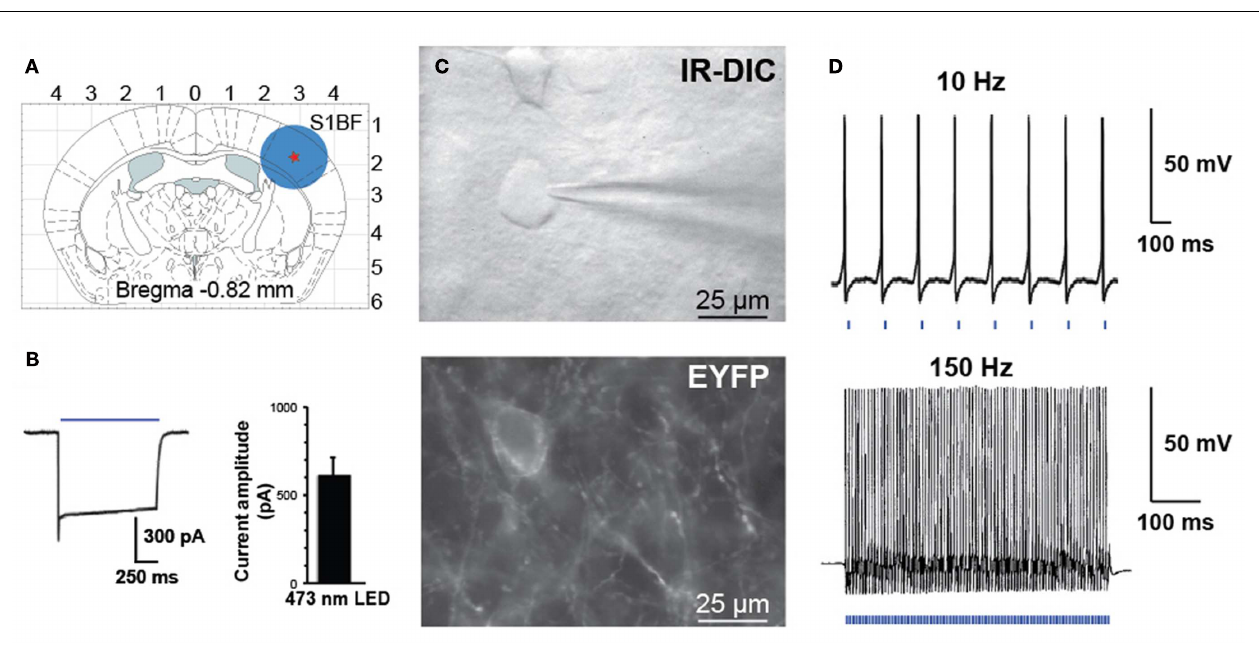
cells in three animals, 1s stimulus, 35mWmm − 2 output power). (C) Bright field (top panel IR-DIC) and fluorescence (bottom panel EYFP) images in the region of recorded neurons. (D) Whole-cell current-clamp recording of PV interneuron expressing ChETA-EYFP in response to patterned light stimulation at 10 or